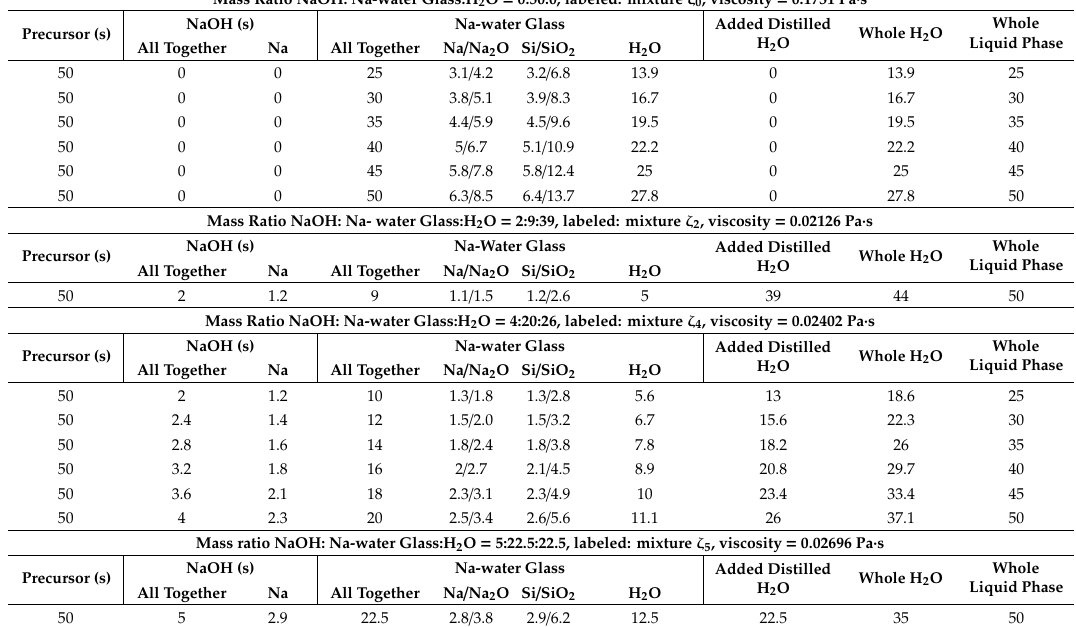
Table 1. Recipes for preparation of alkali activated materials with mass of all ingredients, i.e., Na, Si, and H 2 O. Combinations of ingredients for AA closest to literature’s ratio of amount of substance n Al :n Si :n Na = 1:1:1.9 [34], that should give with fly ash the highest compressive strength and avoid e ffl orescence, are coloured. Mixtures are labeled with ζ xy , where x is amount of NaOH (s) in 50 g of liquid phase, and y is amount of liquid used with 50 g of